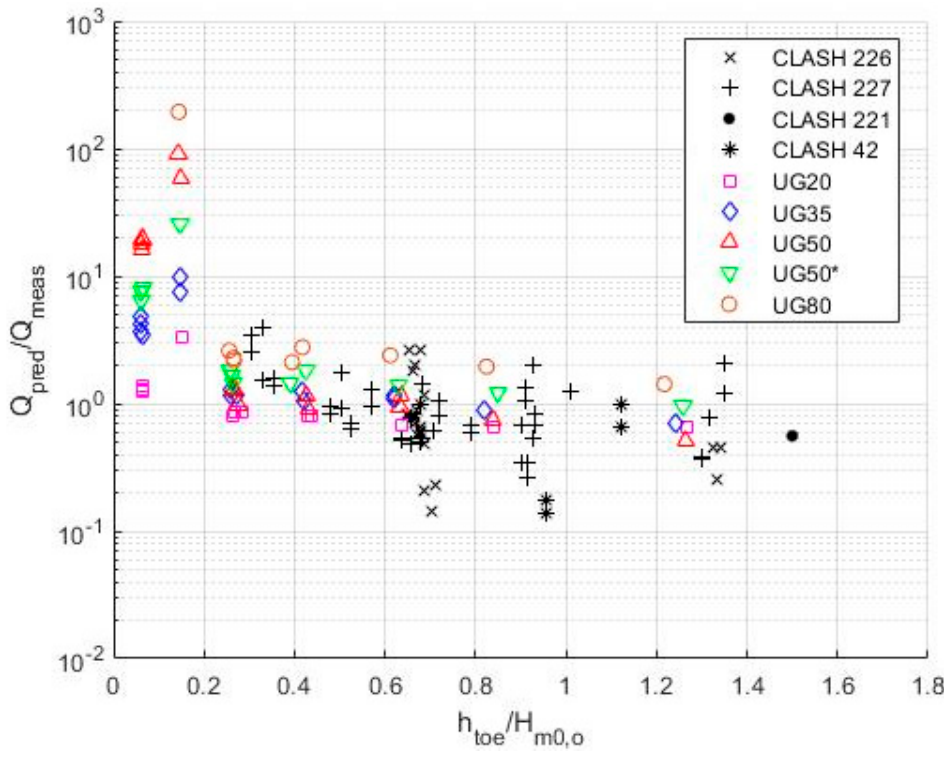
Figure 7. Ratio of dimensionless predicted by Van Gent [12] to measured overtopping discharge versus the relative water depth.